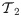
The transformation T2 in the proof of Proposition 21.